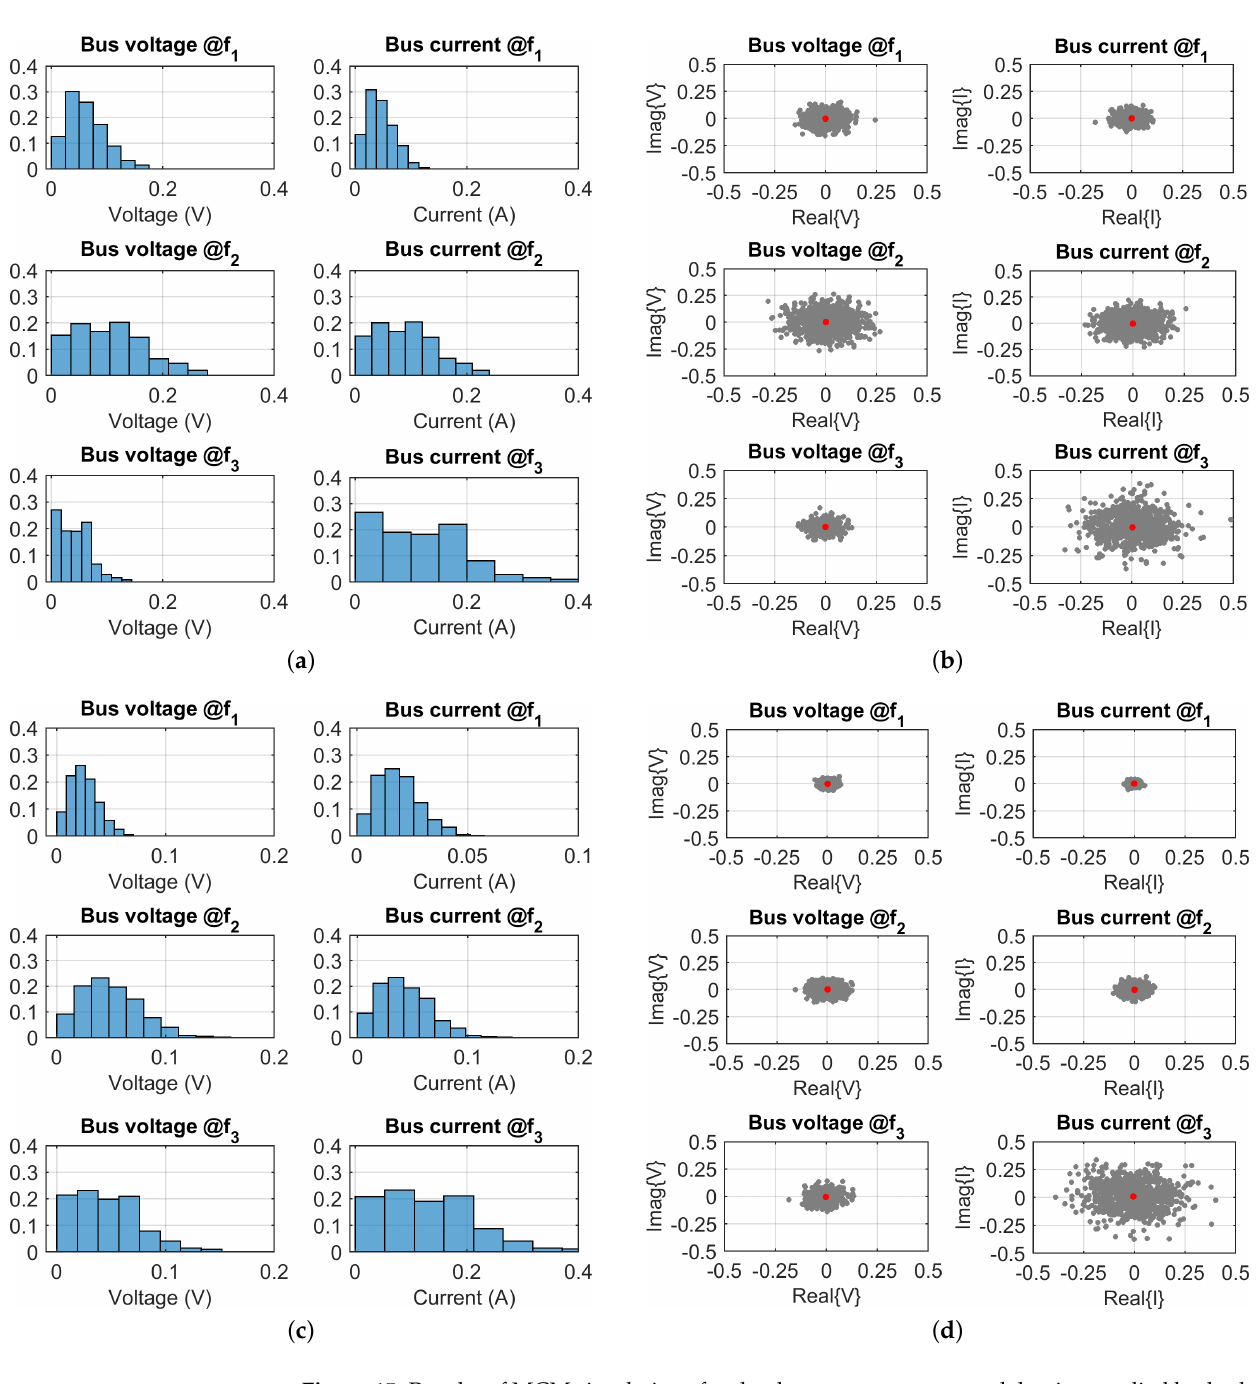
Figure 15. Results of MCM simulations for the three-converter network having applied both phase and frequency random distribution ( [ 0 − 2 π ] for phase and [ − 1%, + 1% ] for frequency, with uniform distribution); network in proximal converter configuration, separated by 5m of line cable segments: ( a ) histogram of spectral components with 200Hz resolution; ( b ) scatter plot of spectral components with 200Hz resolution; ( c ) histogram of spectral components with 500Hz resolution; ( d ) scatter plot of spectral components with 500Hz